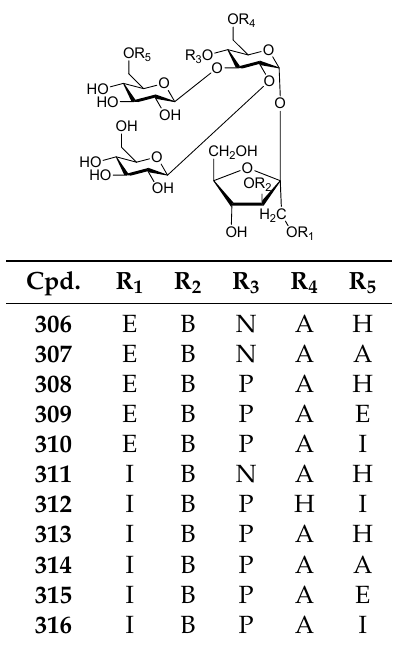
Figure 63. Structures of compounds 306 – 316 .